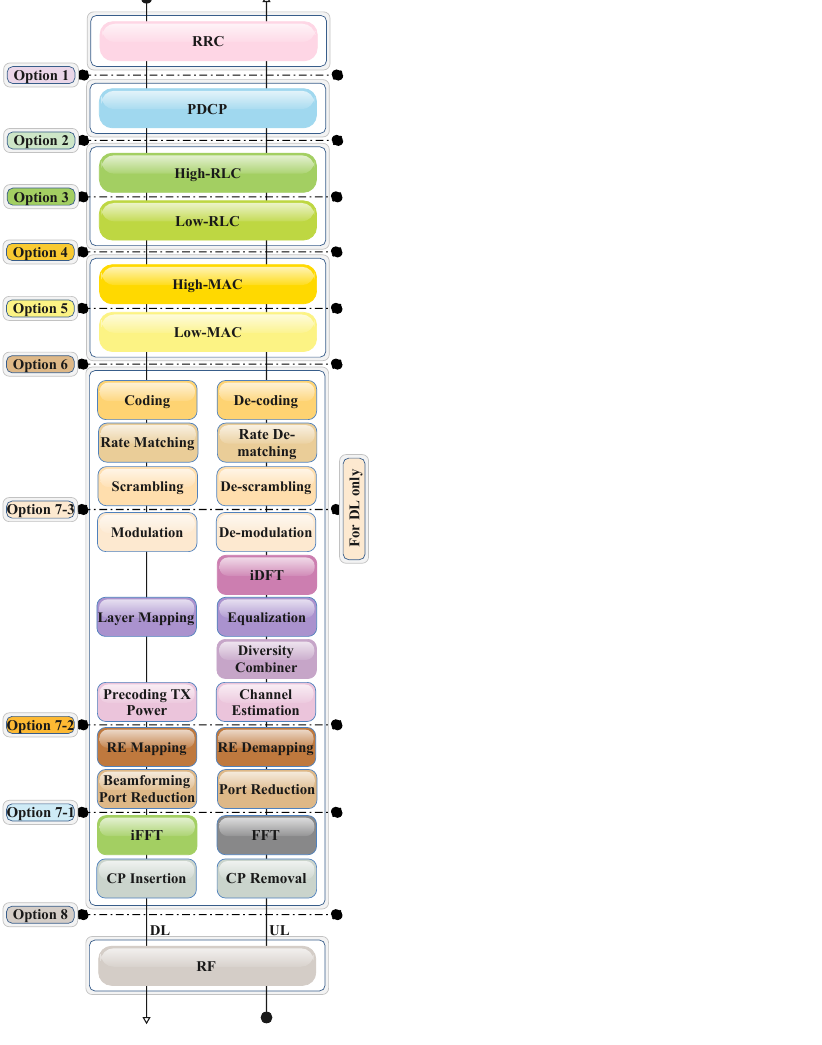
Figure 28. Functional split options between CU and DU with emphasised PHY layer (adapted from